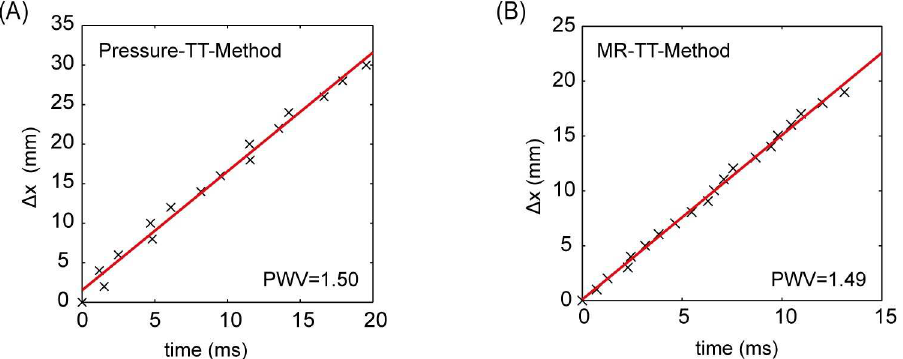
Fig 5. Validation of MR multi-point TT-measurement for global PWV. Direct comparisonof the transit time measurements using a pressuresensor ( A ) and the correspondingMR multi-point TT-measurements ( B ) in the PVA-C